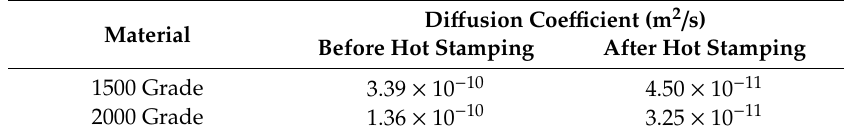
Table 3. Diffusion coefficient for the two grades steels as a function of thermal treatment.